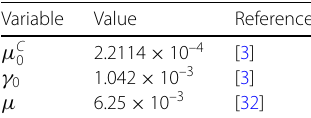
Table 2 Parameter value of the SIR fuzzy model for COVID-19 in Indonesia